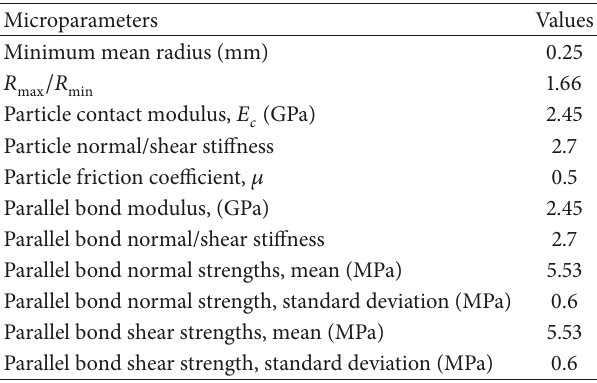
Table 3: Microscopic parameters for rock